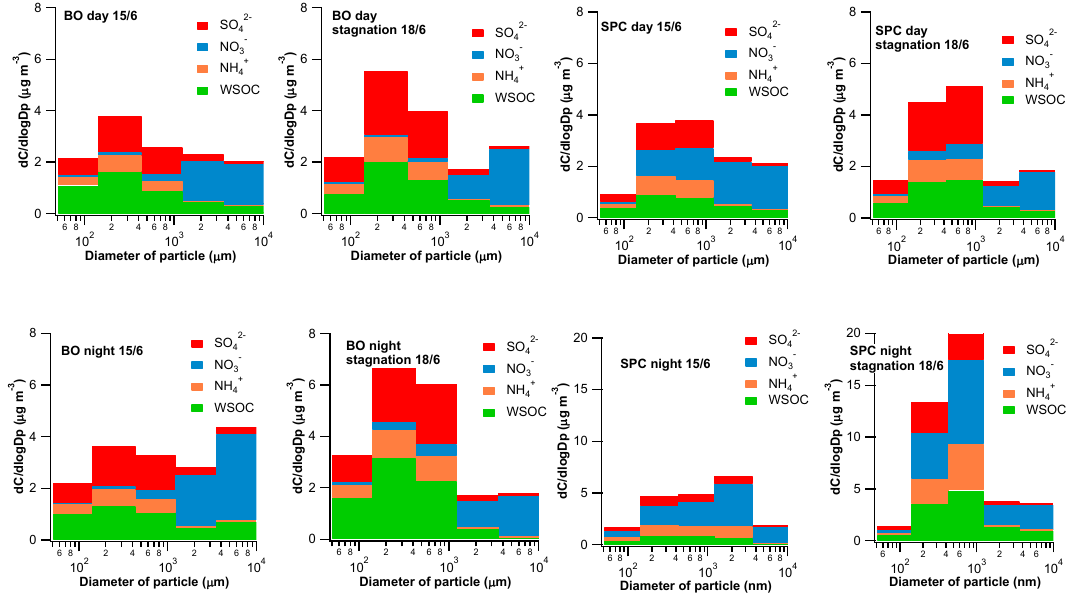
Figure 6. Size-resolved aerosol composition for BO and SPC during day (top) and night (bottom), respectively, during one day characterized by background conditions (15/6) and during one day under stagnant conditions (18/6) (notice the different scale for concentrations in the bottom right panel).